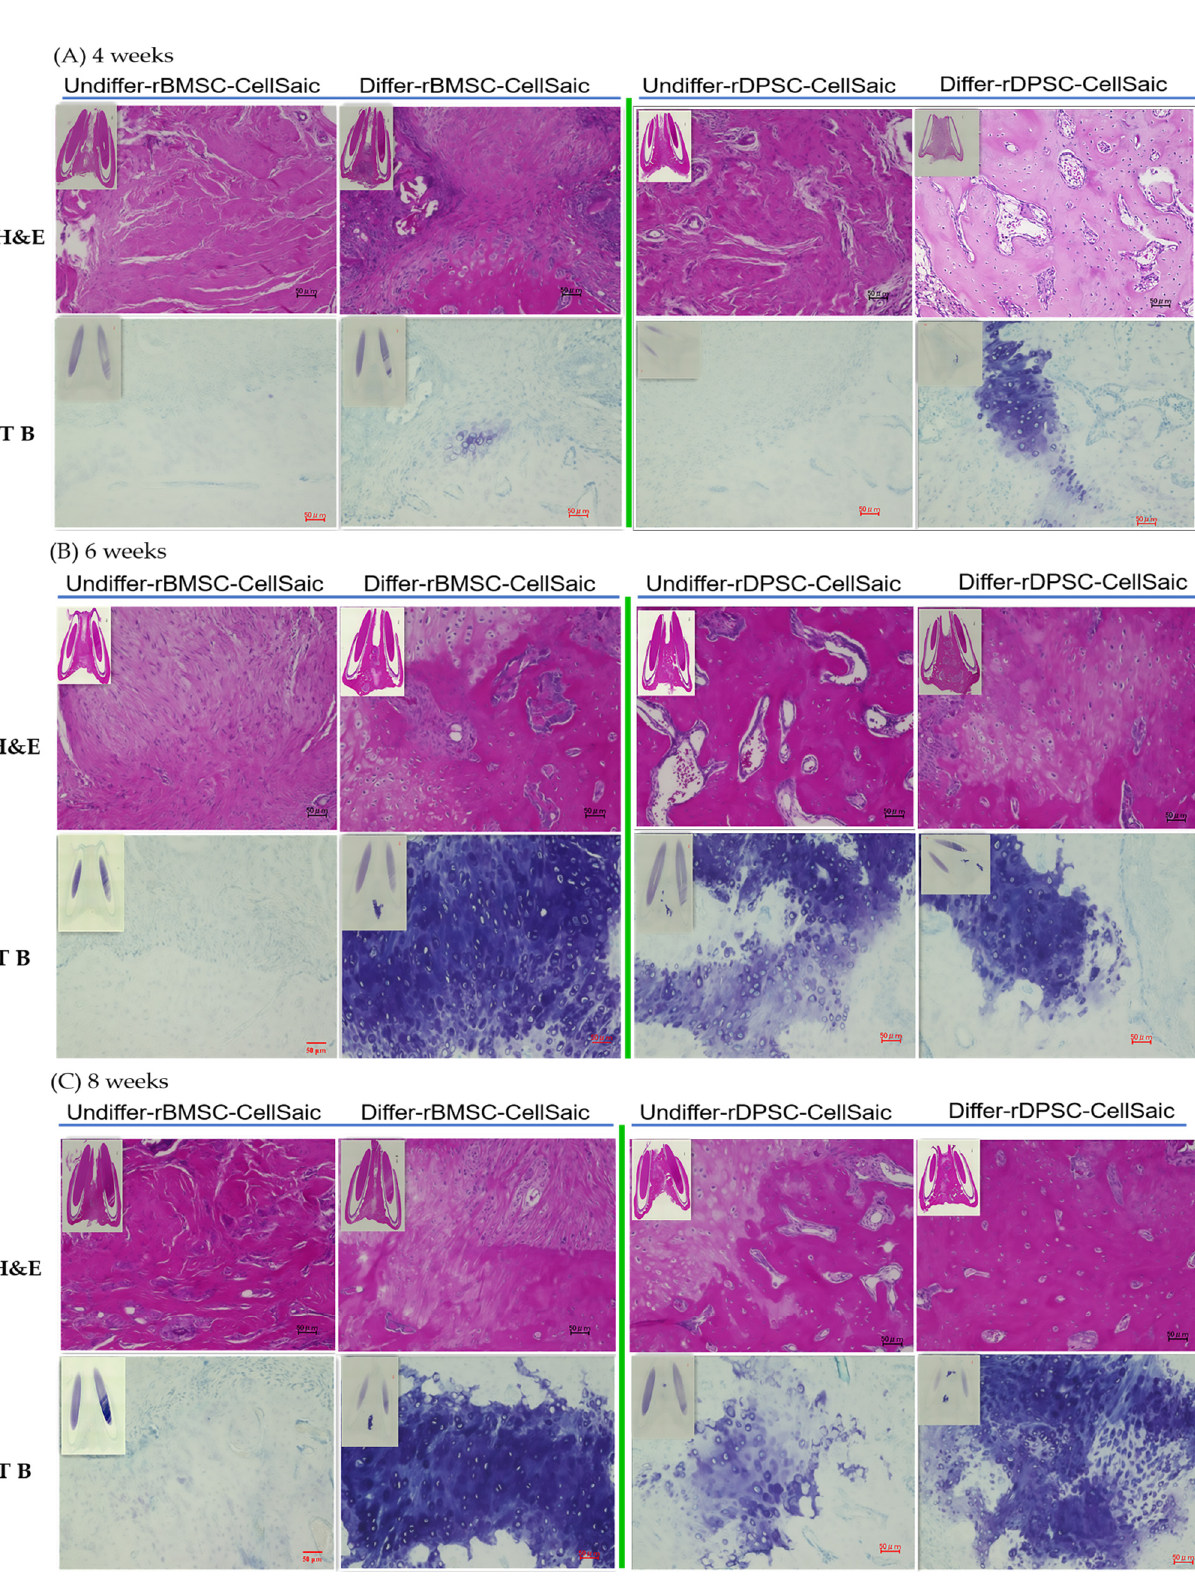
Figure 12. Histological images of bone regeneration at ( A ) 4 weeks, ( B ) 6 weeks, and ( C ) 8 weeks. Sections were stained with hematoxylin–eosin (H&E) and toluidine blue (TB). Upper, small inset image: the image under a low magnification lens; bottom image: high magnification image (scale bar = 50 µm).